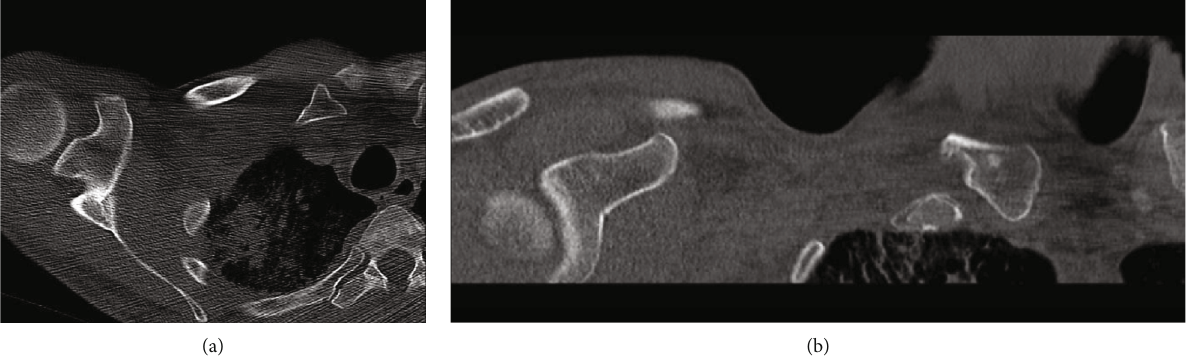
Figure 2: CT images fi ve months after the initial injury showing a right medial clavicle fracture nonunion (a) with sclerotic changes of the medial clavicle fragment (b).